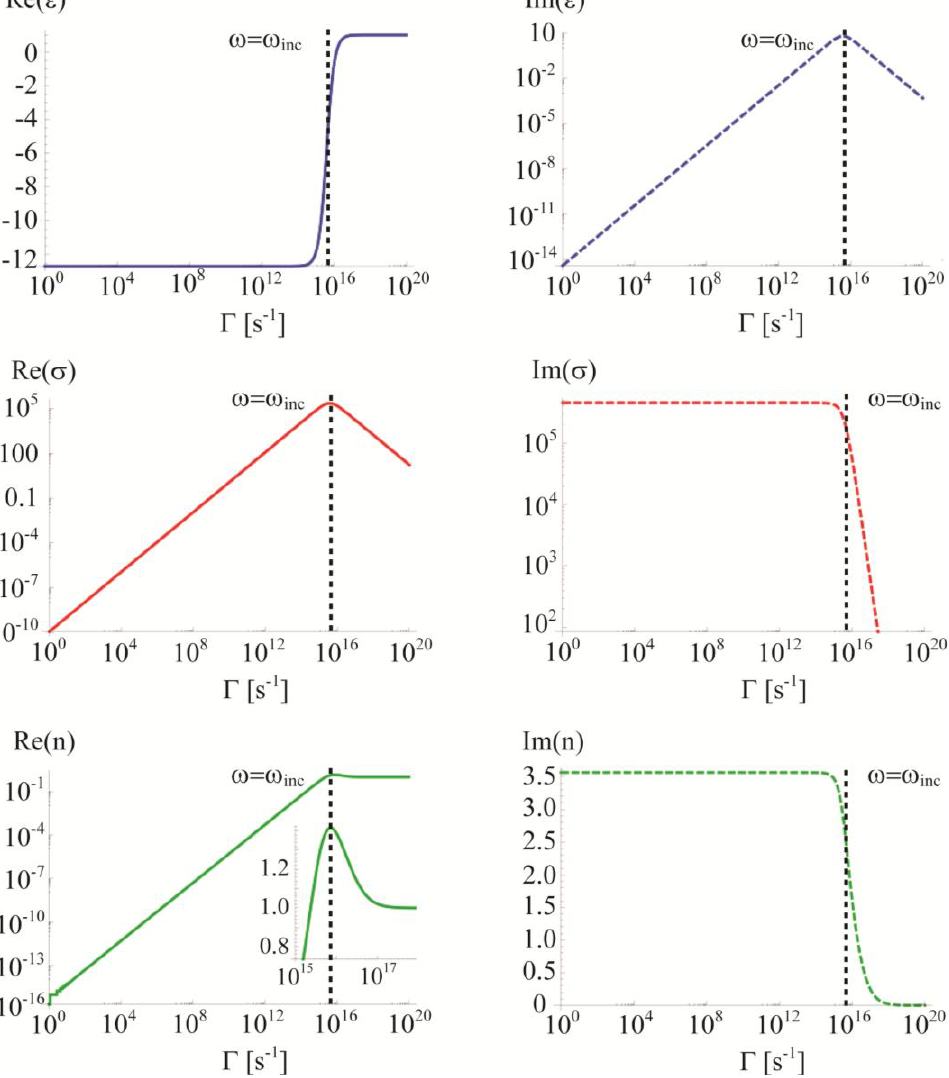
Figure 3. Real and imaginary parts of permittivity ( ε ), conductivity ( σ ) and refractive index ( n ) over a wide range of values of the damping factor at the frequency ω